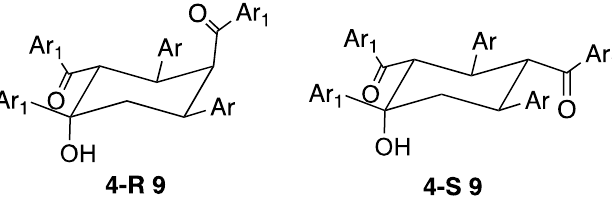
Figure10. Thestructuresofthe3:2cyclohexanolderivativesarisingfromthecyclizationofthetriketones. Figure 10. The structures of the 3:2 cyclohexanol derivatives arising from the cyclization of the triketones.